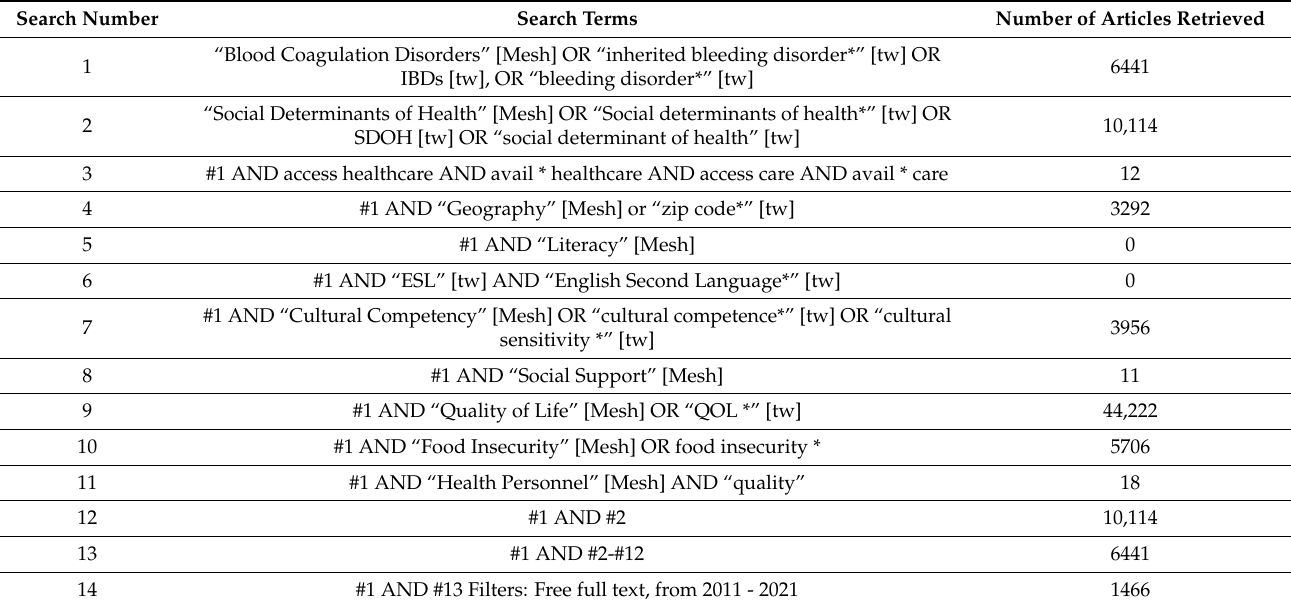
Table 1. Structure of Search and Search